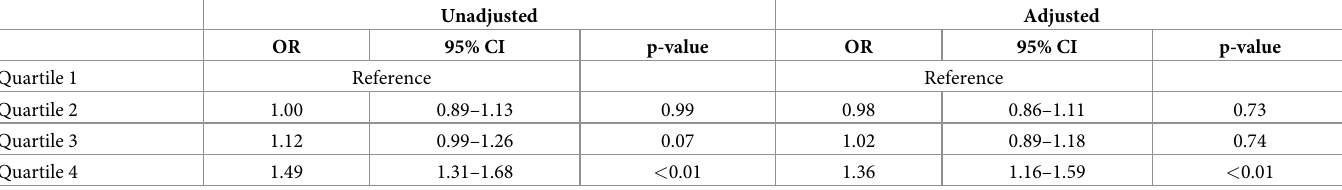
Table 3. Odds ratios for non-attainment of optimal blood pressure level by quartiles of baseline uric acid concentration.